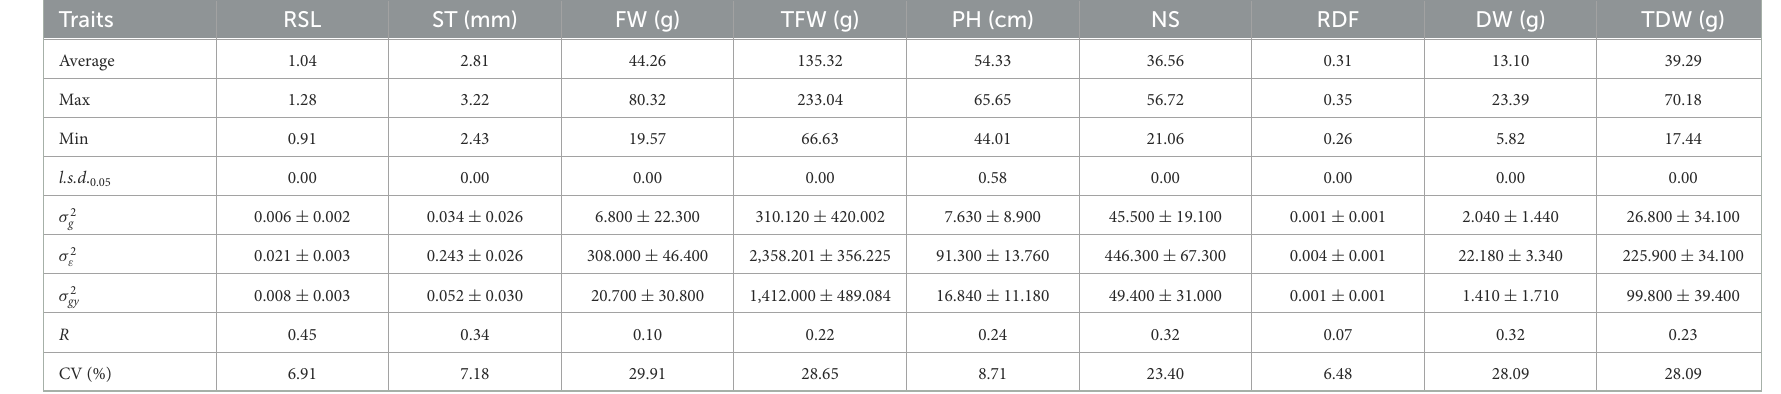
TABLE 3 Average, maximum, minimum, least significant differences ( l.s.d. 0.05 ), estimated genotypic ( σ 2 g ) and experimental error ( σ 2 ε ) variance components and associated standard errors ( ± SE), and mean repeatability ( R ) estimated from the 44 varieties of alfalfa evaluated in 2019. Traits